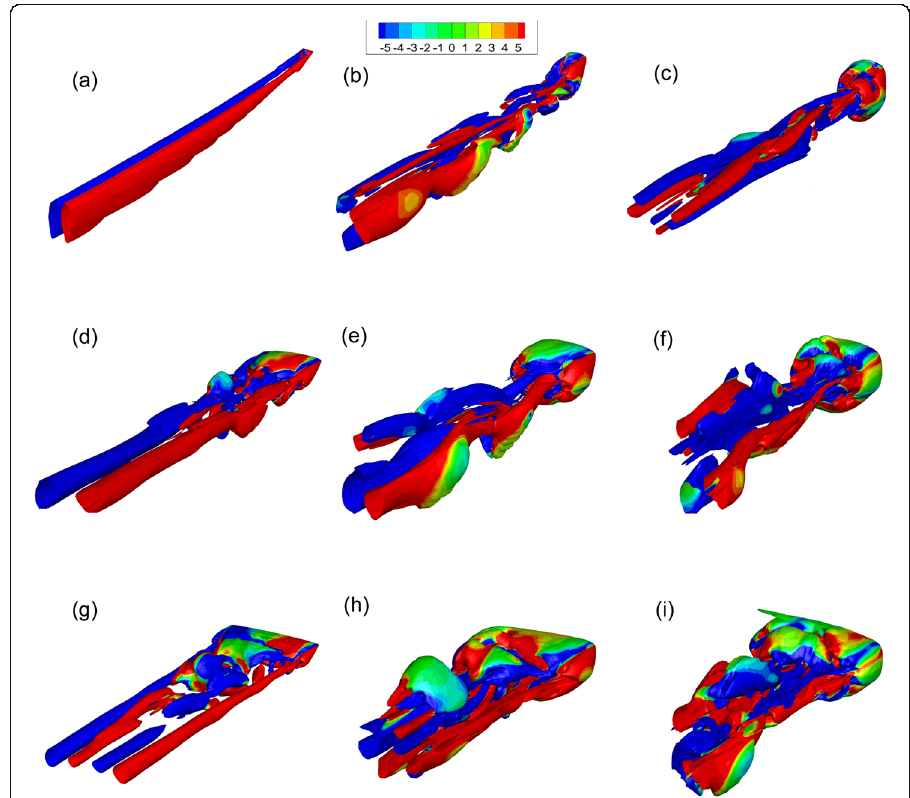
Fig. 10 Iso-surface of λ 2 criterion colored by streamwise vorticity at a ) α = 30°, AR = 0.5, b ) α = 60°, AR = 0.5, c ) α = 90°, AR = 0.5, d ) α = 30°, AR = 2, e ) α = 60°, AR = 2, f ) α = 90°, AR = 2, g ) α = 30°, AR = 5, h ) α = 60°, AR = 5, i ) α = 90°, AR =